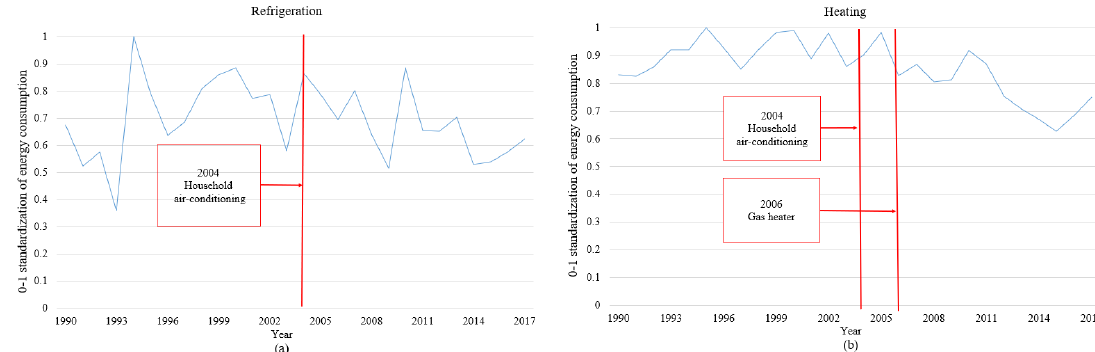
Figure 6. The policy identification results of the tertiary industry (( a ) Refrigeration; ( b ) Heating; ( c ) Hot water; ( d ) Kitchen; ( e ) Lighting, power and others; ( f ) All energy consumption).